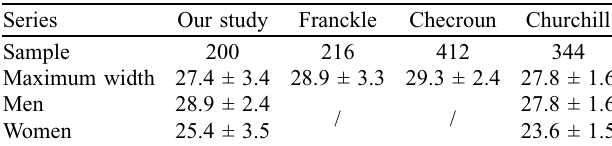
Table 2. Results of mean maximum width